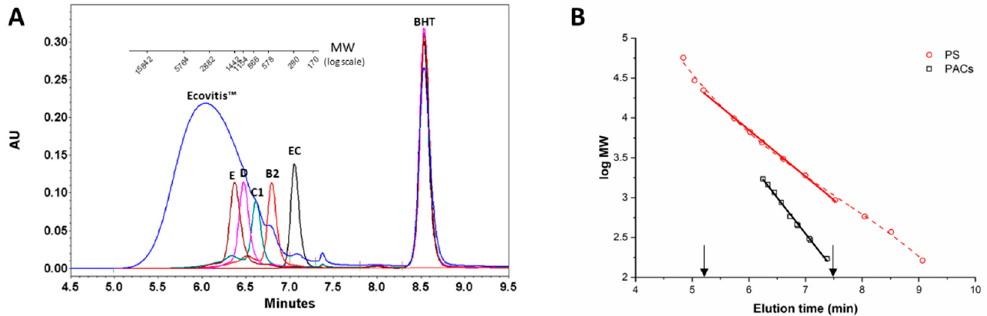
Figure 2. Gel permeation chromatography (GPC) data: ( A ) Gel permeation chromatograms of procyanidin standards (epicatechin EC, dimer B2, trimer C1, tetramer D, and pentamer E) overlaying the chromatogram of Ecovitis™ (blue line). Elution with THF/aqueous LiBr 12 mM (95:5, v / v ). The bar of the corresponding molecular mass over elution time is shown above; ( B ) calibration curves of PACs (GA, TA, EC, ECG, EGC, EGCG, PC ‐ B2, PC ‐ C1, PC ‐ D, PC ‐ E, and black squares) and polystyrene (red circles). For polystyrene, the linear part of the calibration plot (MW range 935–22290) is shown as solid red line. Arrows indicate the observed linear range for the GPC column.